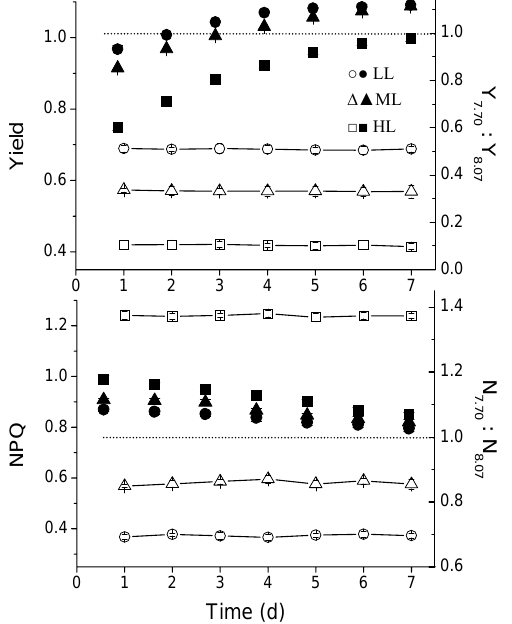
Figure 3. Effective quantum yield (Yield) (a) and non- photochemical quenching (NPQ) (b) of P. globosa grown at pH 8.07 (open symbols), and the ratios (solid symbols) of either the yield or the NPQ at pH 7.70 to that at pH 8.07 under different irra- diance levels (LL, 25; ML, 200; HL, 800µmol photons m − 2 s − 1 ). The data represent the means ± SD ( n = 3, triplicate cultures).